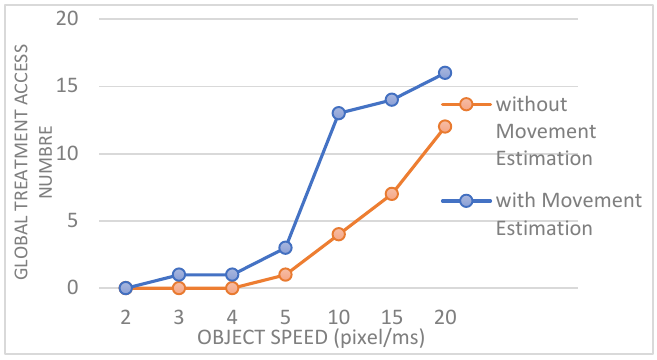
Figure 11. Frequency of global treatment access .